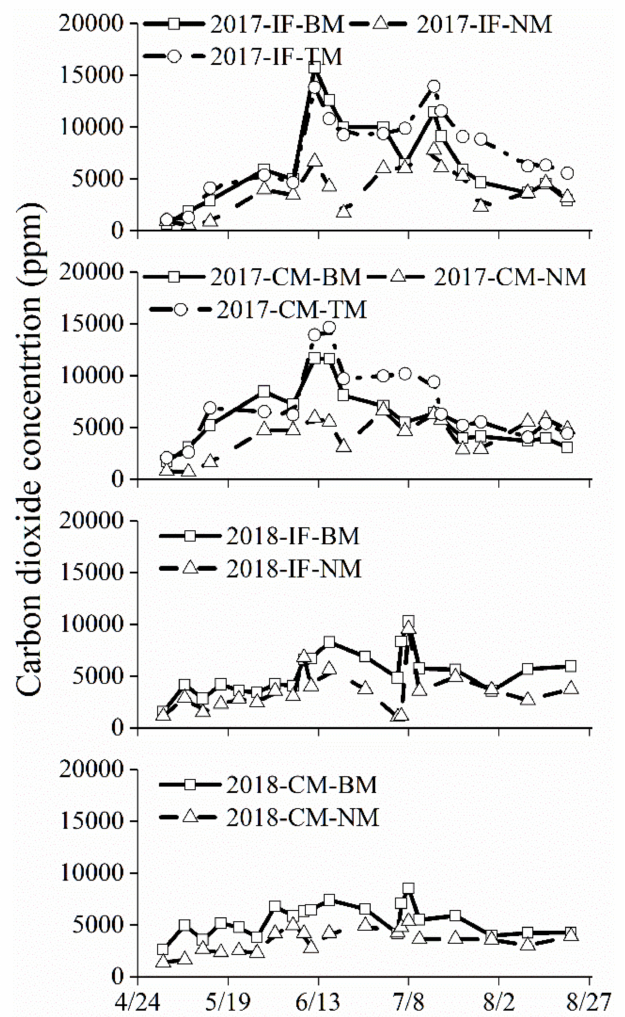
Figure 3. Carbon dioxide concentration at 20 cm soil depth for the di ff erent kinds of fertilizer and di ff erent soil surface treatments for potato production at Wuwei, China: inorganic fertilizer (IF) and cattle manure (CM); black plastic-film mulch (BM), transparent plastic-film mulch (TM) and no mulch (NM) during 2017 and 2018. No statistical analyses could be applied to these data because each value represents a single plot of each